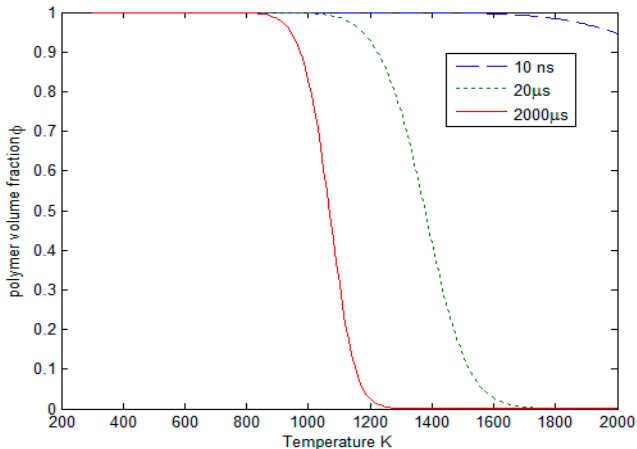
Figure 3. Polymer volume fraction at different temperatures in a certain reaction time (10 ns, 20 µ s, 2000 µ s).